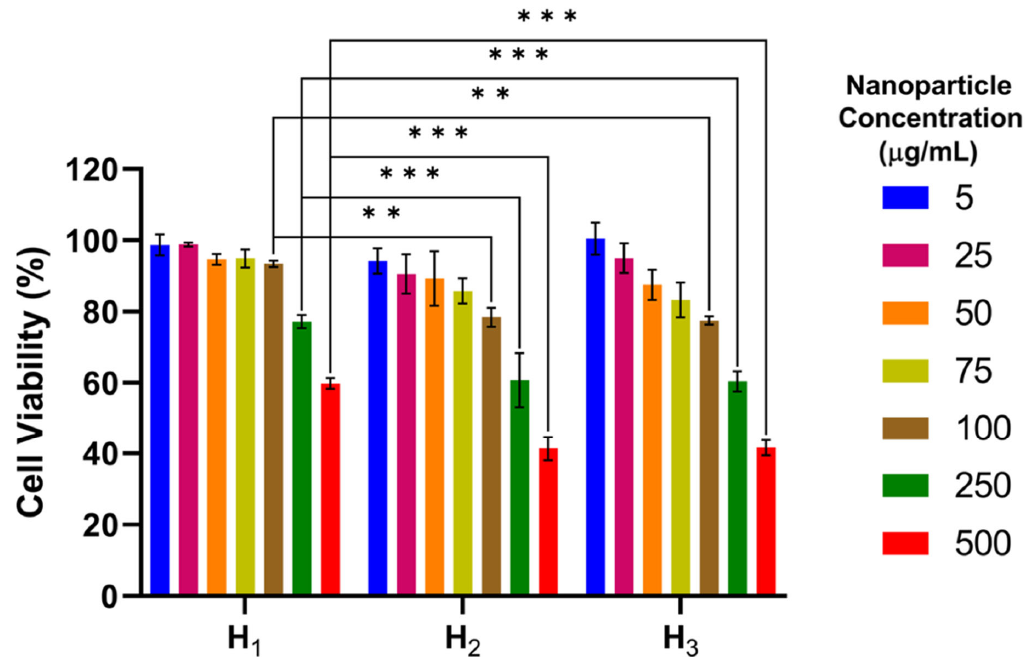
Figure 4. Cytotoxicity of H 1 , H 2 , and H 3 SNPs in RAW 264.7 macrophages after incubation for 24 h. Results suggest that all particles are well tolerated by macrophages in concentrations below 100 μ g mL − 1 . The graphs are plotted as mean ± SD of three independent experiments (** p value < 0.01, *** p value < 0.001).